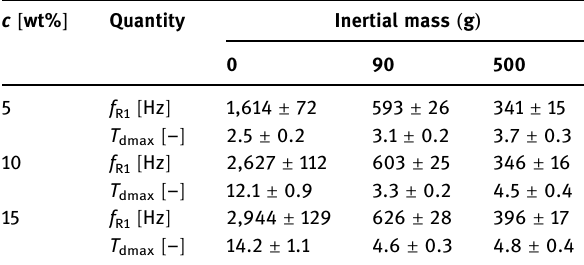
Table 1: First resonance frequency f R1 and the corresponding maximum displacement transmissibility T dmax of the investigated composites as induced by harmonically excited vibration; c – perlite concentration